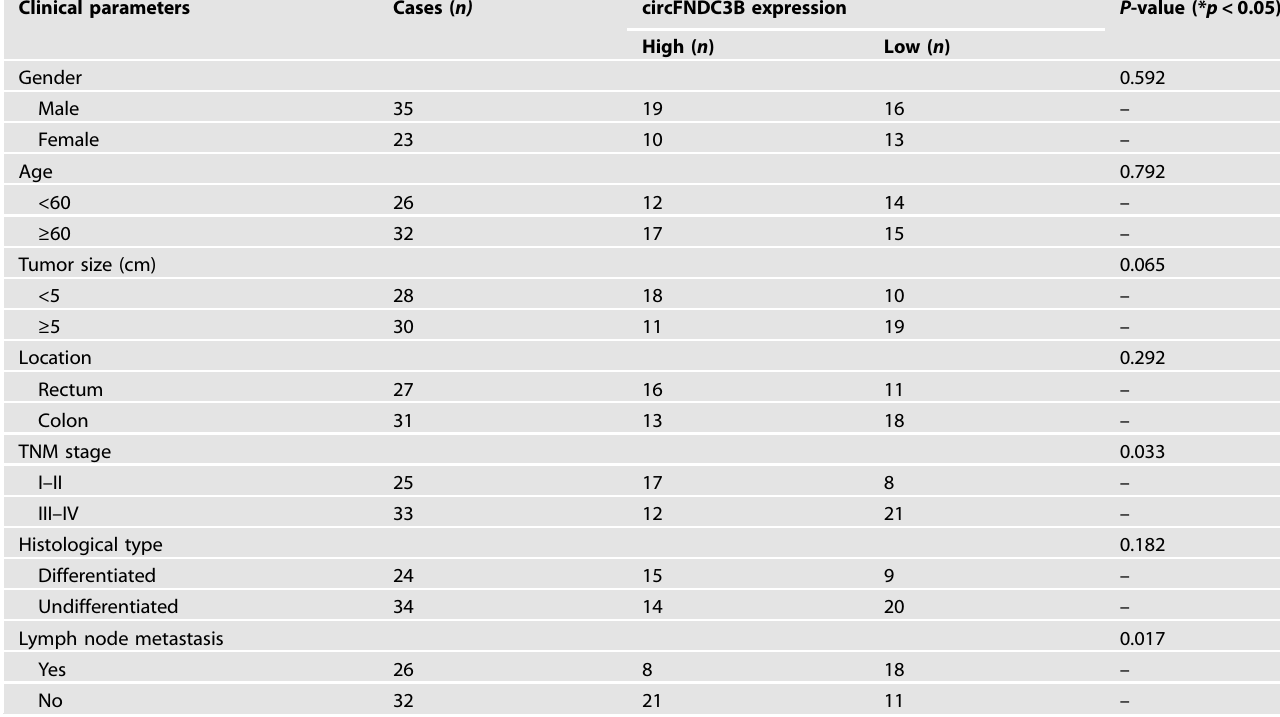
Table 2. Association between circFNDC3B expression levels and clinicopathological characteristics of CRC patients. Clinical